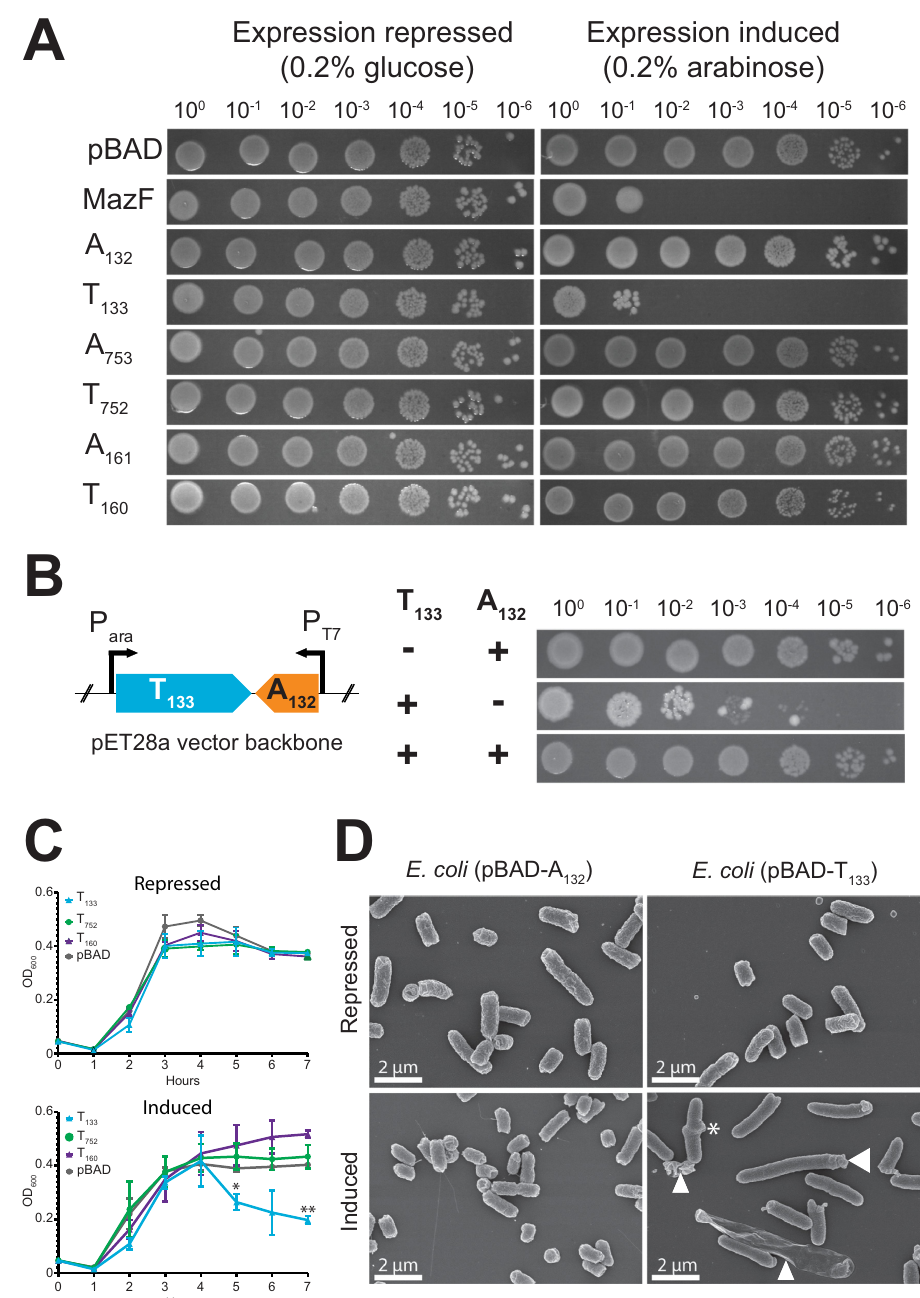
Fig 4. Toxicity of recombinant candidate TA systems in E . coli . (A) Spot assays of E . coli LMG194 in response to induction or repression of heterologous expression of the different toxins, antitoxins and entire TA systems. The empty vector pBAD/His was used as negative control and the toxin MazF was used as positive control. Each data point represents the mean of three biological replicates, bars indicate standard deviation. (B) Neutralization experiments employing a dual expression system based on the pET28a vector enabling the expression of the two TA partners individually or in combination. Schematic representation of the construct is displayed (left) while the spot assay results are presented (right). A toxic effect is only observed after induction of the toxin but neutralization of the toxin activity was obtained via concomitant expression of the antitoxin. (C) Growth curves of E . coli LMG194 in response to induction or repression of heterologous expression of T 133 , T 160 , T 752 and empty vector pBAD/His. Each data point represents the mean of three biological replicates, bars indicate standard deviation. The p-values are displayed ( � p � 0.05, �� p � 0.01).). (D) Scanning electron micrograph (magnification 10,000x) displaying morphological changes of E . coli LMG194 observed 7 hours after the induction of T 133 and A 132 recombinant proteins. Blebbing at the pole is indicated by an arrow, z-shaped cells by asterisk and cell debris by